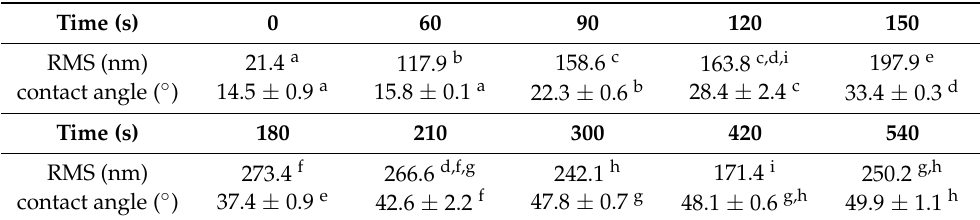
Table 1. RMS and contact angle data of the cleaved mica and PDA/mica prepared by immersion for different times (60, 90, 120, 150, 180, 210, 300, 420, and 540 s),